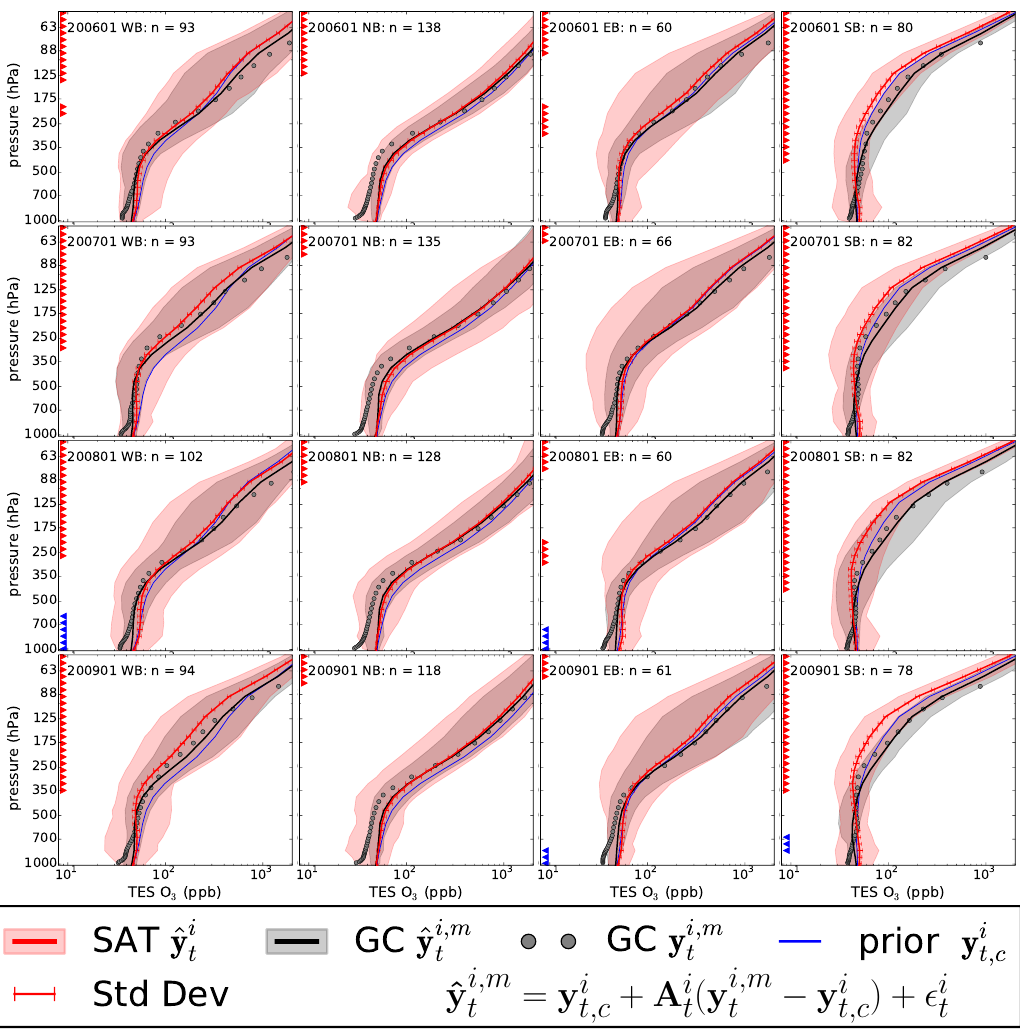
Fig. A1. Ozone retrievals from TES for January of 2006, 2007, 2008, and 2009 for each boundary face (West, North, East, South) observed by TES (TES b y i t , red) and as retrieved from GEOS-Chem (GC b y i,m t , black). GEOS-Chem retrievals are calculated by applying the TES averaging kernel to the GEOS-Chem prediction (GC b y i,m t , grey dots), which relies on the a prior (a prior b y i t,c , blue). Lines or dots represent median values, the shaded area represents the range of values, and TES uncertainty is shown as error bars. Red and blue triangles show high (red) and low (blue) biases as defined by 2 times the TES error for the median